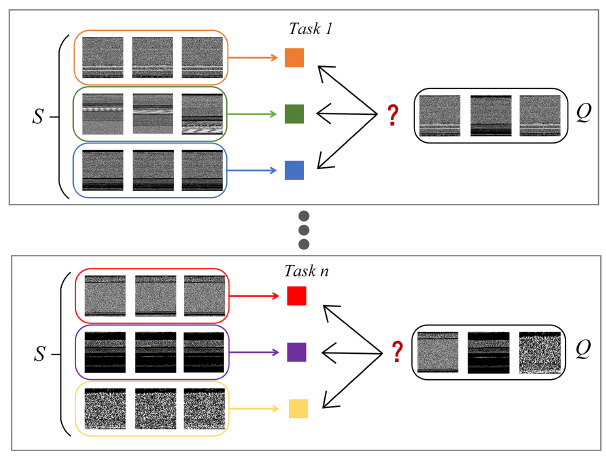
Figure 2. Task structure for malware few-shot